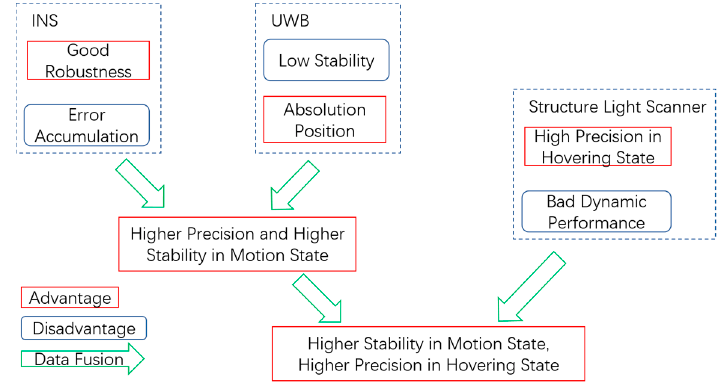
Figure 1. The advantages and disadvantages of a heterogeneous sensing system.